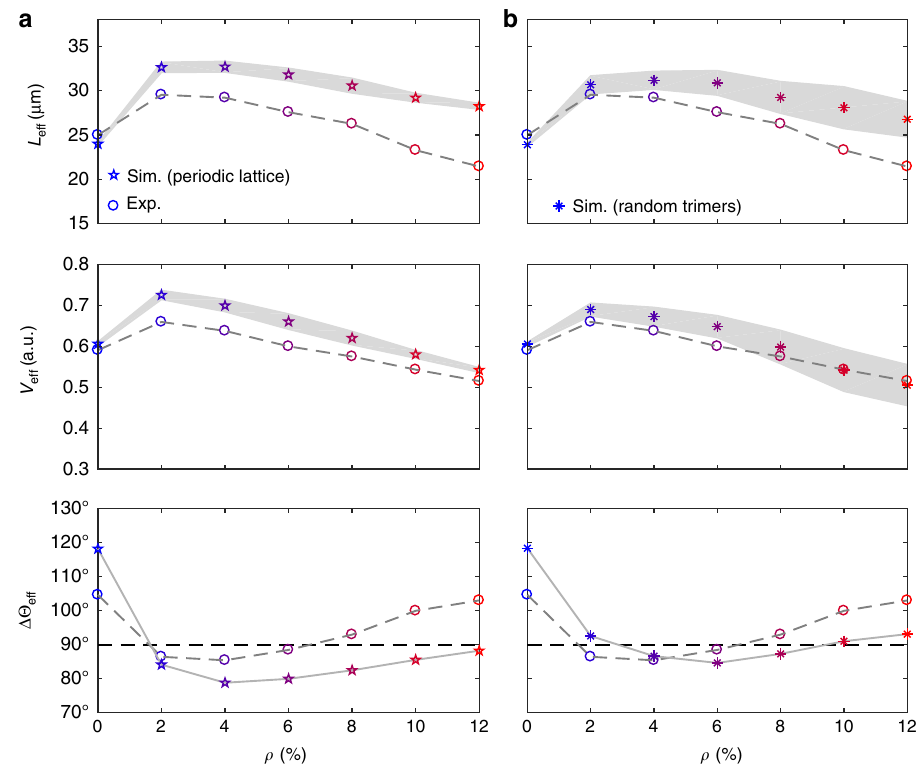
Fig. 6 In fl uence of obstacle distribution. a , b Simulated average effective propagation distance L eff , normalised average effective propagation speed V eff and average change in effective propagation direction ΔΘ eff as a function of the obstacle density ρ for chiral active particles self-propelling through a circular area of radius R = 25 μ m containing obstacles distributed according to a triangular periodic lattice ( a ) (Supplementary Fig. 5b and Methods) and a random distribution of non-overlapping trimers ( b ) (Supplementary Fig. 5c and Methods). The interactions with the obstacles include all three cell – obstacle interaction terms: repulsive interactions, forward-scattering events and tumble-collisions (Methods). Each value is obtained from averaging over 3000 different trajectories. The shaded area around the average values of L eff and V eff represents one standard deviation. The solid line connecting the values of ΔΘ eff is a guide for the eyes. The corresponding probability distributions of the change in effective propagation direction Fig. 8. The corresponding experimental values (Figs. 1 and 2) are shown for reference (circles)